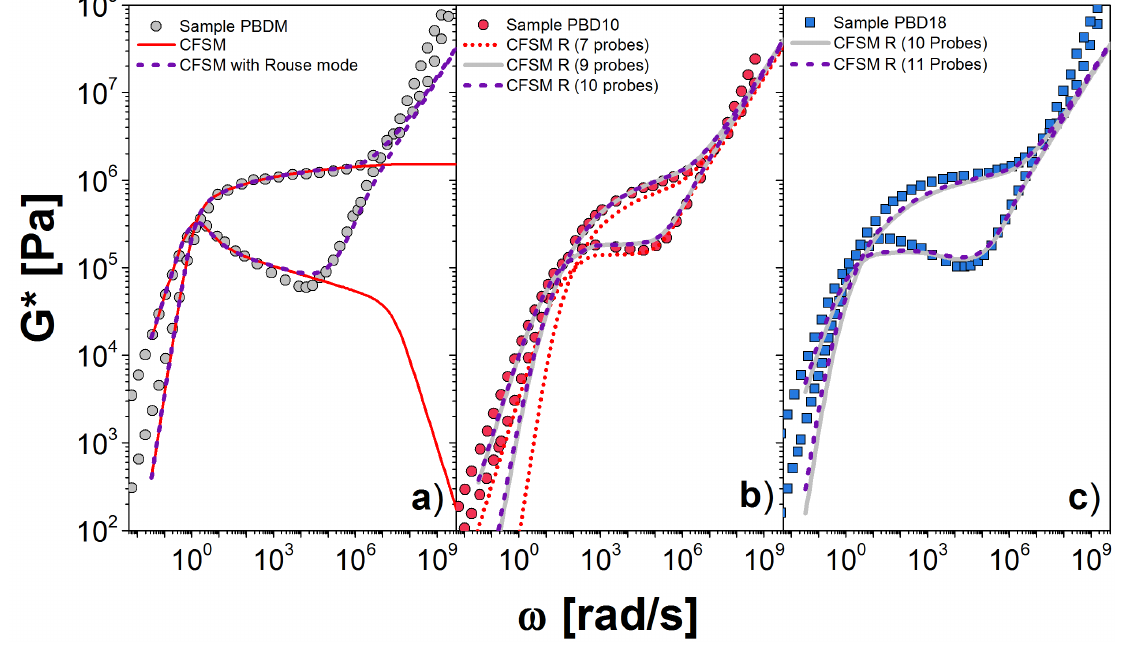
Figure 7. Dynamic moduli for PBD for: ( a ) monodisperse and polydisperse linear chains; ( b ) PBD10; and ( c ) PBD18 at 30 ◦ C. Symbols are the experimental results and lines the theoretical predictions. In ( a ), solid line corresponds to only the CFSM and dashed line to the CFSM including the Rouse modes. In ( b , c) , we show the simulation data, including the Rouse modes, for polydisperse melts using different number of probes to represent the W ( M ) (see Figure 1a).